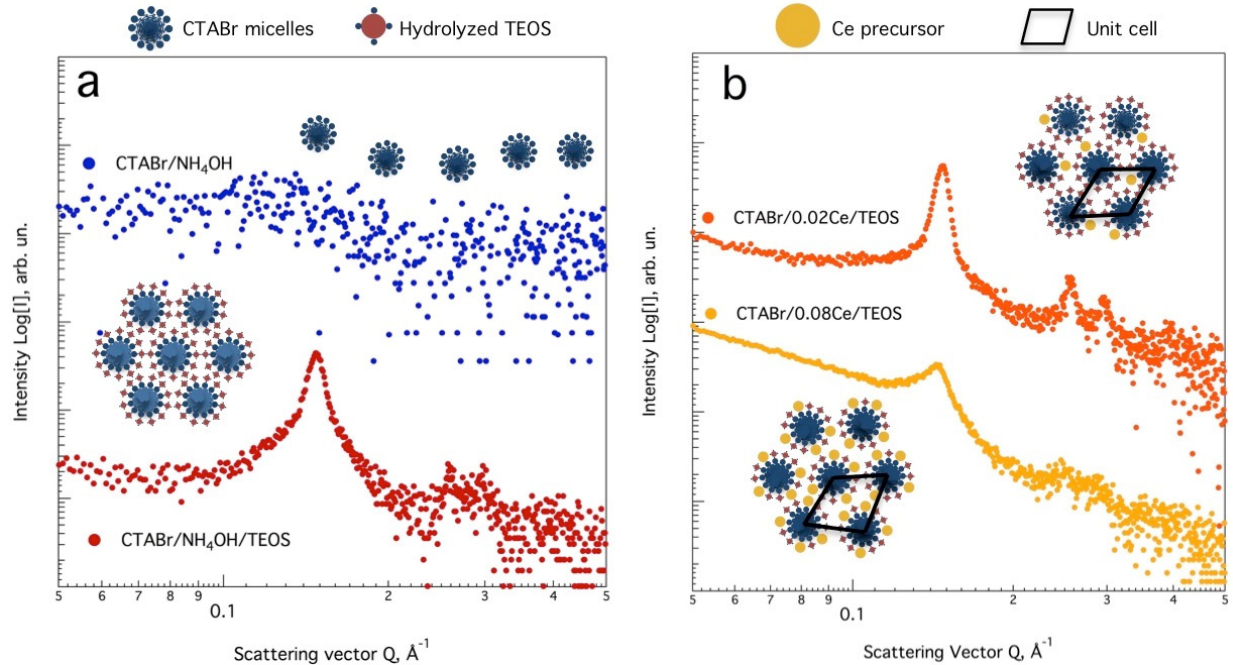
Figure 2. In-situ SAXS measurements for ( a ) CTABr solution, MCM-41 synthesis colloid, and ( b ) colloidal Ce-modified mesoporous silica (using 0.02 and 0.08 Ce/Si molar ratios). Inset graphs, pos- sible formation mechanism for the isomorphic incorporation of the Ce species.